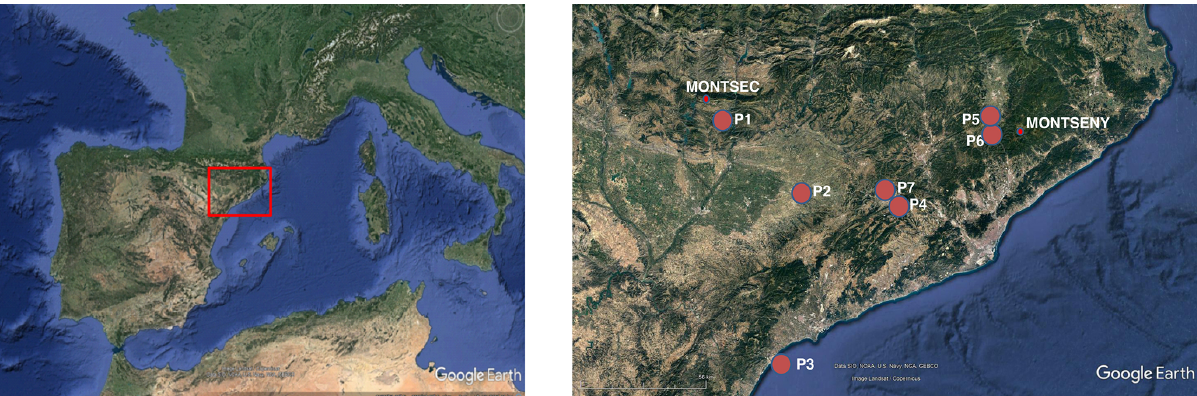
Figure 1. Western Mediterranean basin and zoom over the north-east of Spain with the MSA and MSY stations and the number ID of the instrumented flights (Table 1), with the shaded area indicating the horizontal area where measurements were taken. Satellite view from © Google Earth. Table 1. Flight measurement location and date. Vertical profiles were performed up to heights of 3.5kma . s . l .